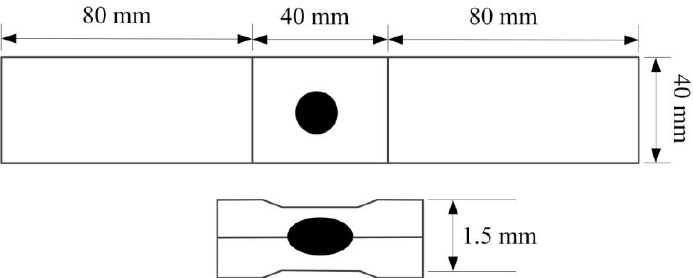
Figure 1. The design of the welded joint.